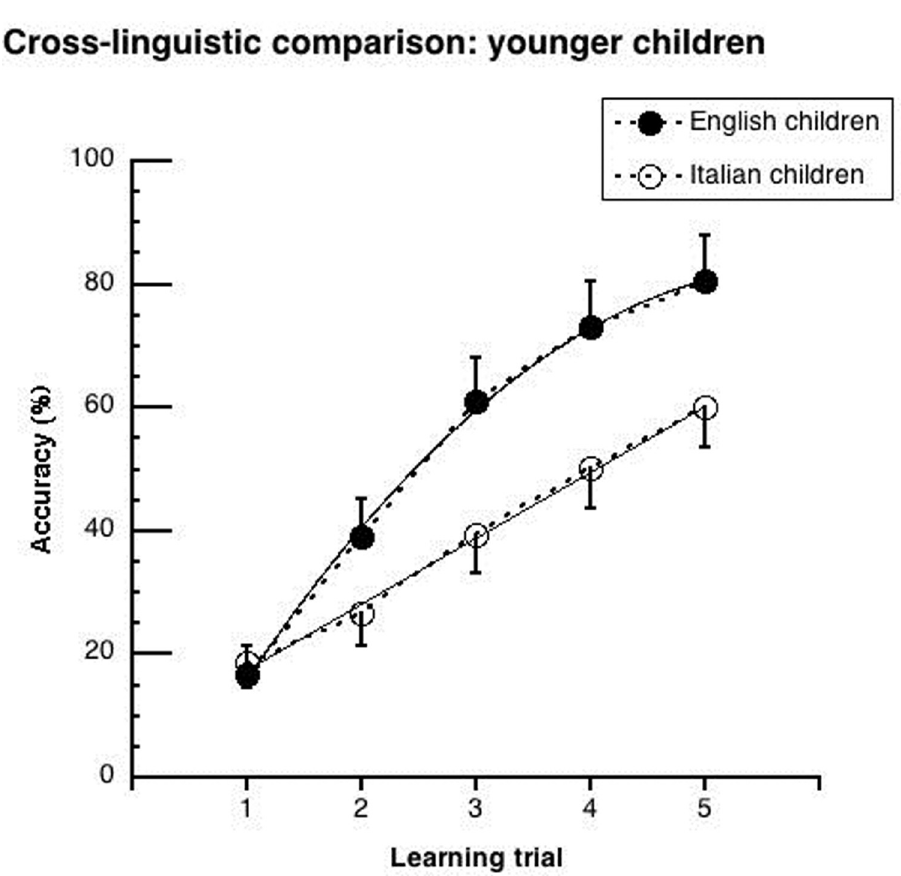
Fig 3. Mean performance (and .05 confidence intervals) of “younger” children on the lexical learning task as a function of trial sequence. Data are separately presented for Italian and English participants. Interpolation is based on significant trends. For the Italian children, a linear regression well explains the data (y = 0.75 + 9.88x; r 2 = .99). For the English children, performance is well explained by the combination of a linear and a quadratic trend (y = -14.59 + 24.02x -1.39x 2 ; r 2 =